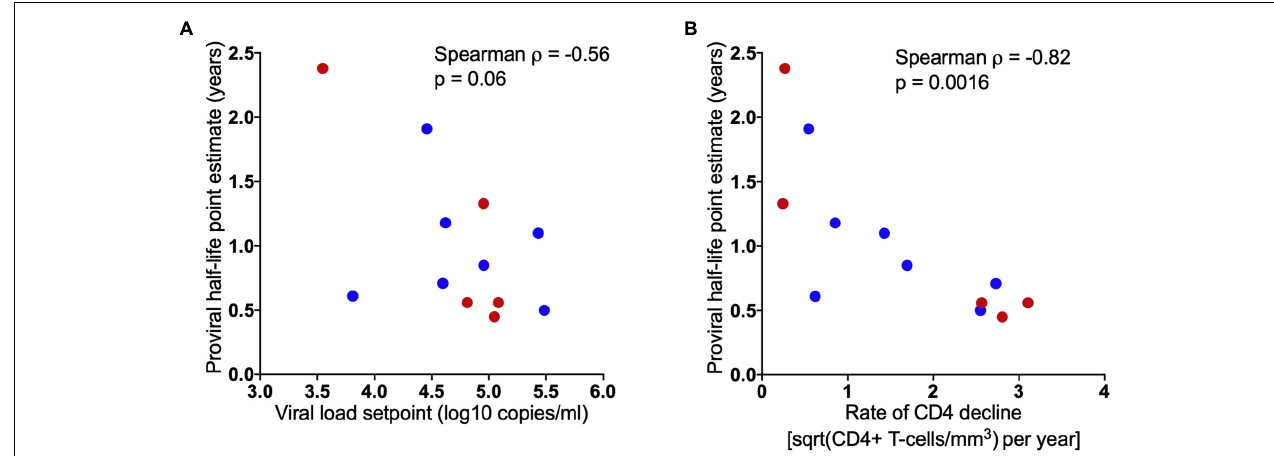
FIGURE 6 | Higher pVL setpoint and rapid rate of CD4+ T-cell decline is associated with faster proviral turnover during untreated infection. Spearman’s correlation showing inverse relationship between model-estimated proviral half-lives and participant set point plasma viral load (A) , and rate of CD4+ T-cell decline (B) . Blue and red dots denote male and female participants,